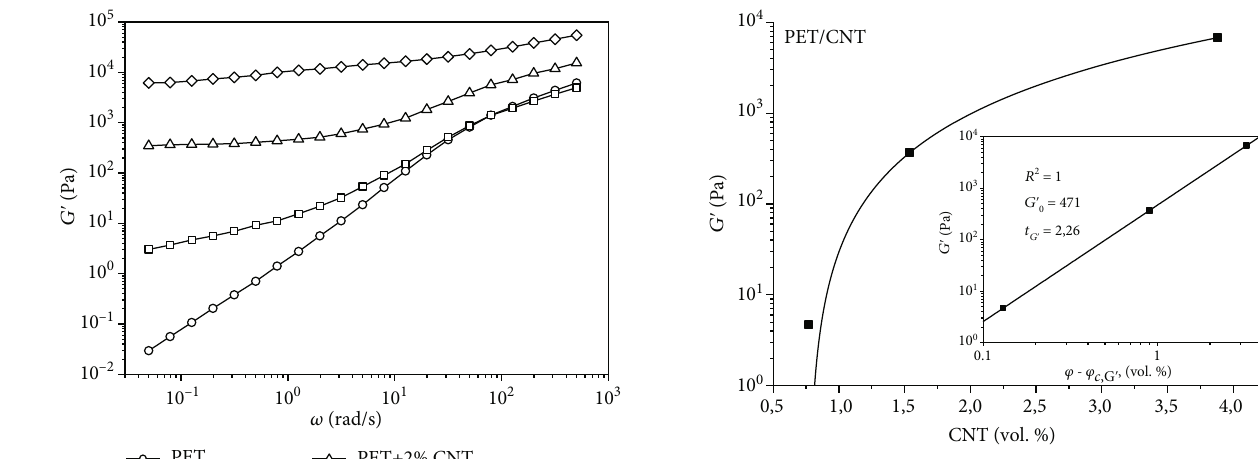
Figure 7: PET/CNT nanocomposite rheological percolation